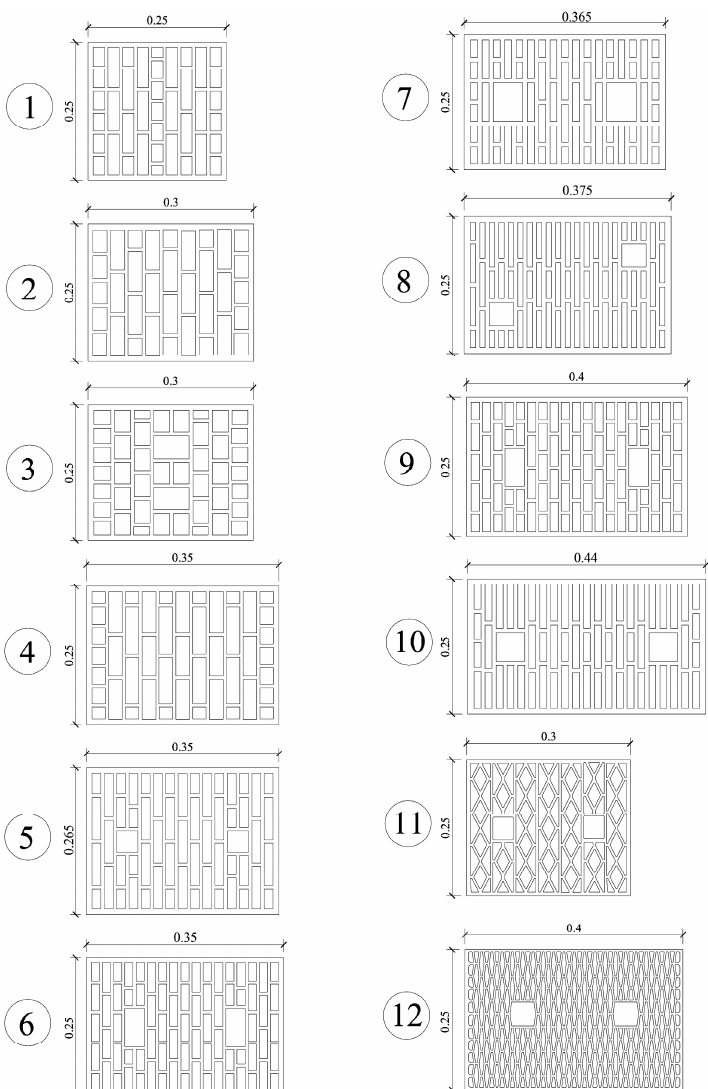
Figure 1. Images of the evaluated blocks (plan